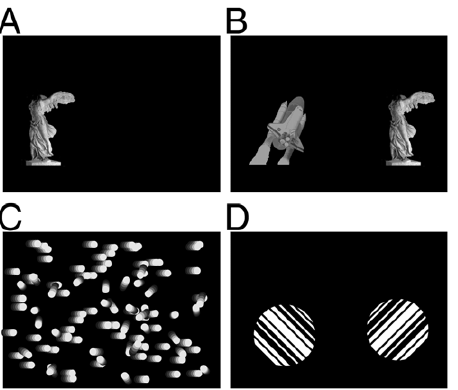
Figure 1. Visual Tasks. A. Schematic of stimulus for Approach Salient Visual Target task. Subjects were rewarded for licking the water port beneath the image of the statue. B. Schematic of stimulus for the Image Discrimination task. Subjects were rewarded for licking the port beneath the statue, not the space shuttle. C. Schematic of stimulus for Motion Discrimination task. Subjects were rewarded for licking the port on the side toward which the coherent dots moved. D. Schematic of stimulus for orientation discrimination task. Subjects were rewarded for licking the port beneath clockwise rotated bars, not counter- clockwise rotated bars.